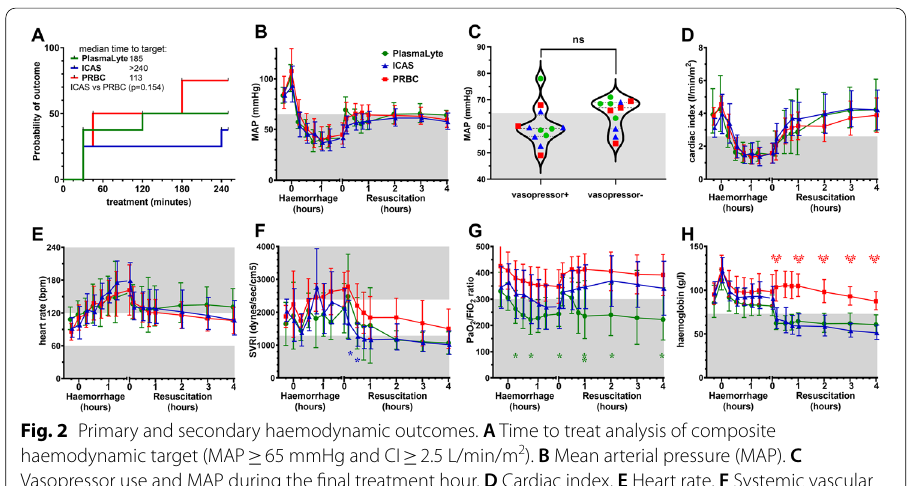
Fig. 2 Primary and secondary haemodynamic outcomes. A Time to treat analysis of composite haemodynamic target (MAP 65 mmHg and CI 2.5 L/min/m 2 ). B Mean arterial pressure (MAP). C ≥ ≥ Vasopressor use and MAP during the final treatment hour. D Cardiac index. E Heart rate. F Systemic vascular resistance index. G P / F ratio; and ( H ) haemoglobin. Shaded areas represent levels outside the normal range, or treatment targets. Data shown as mean or geometric mean according to normality test, with 95% confidence intervals. Mixed model ANOVA with Tukey correction for multiple comparisons; * p < 0.05, ** p < 0.01, *** p <